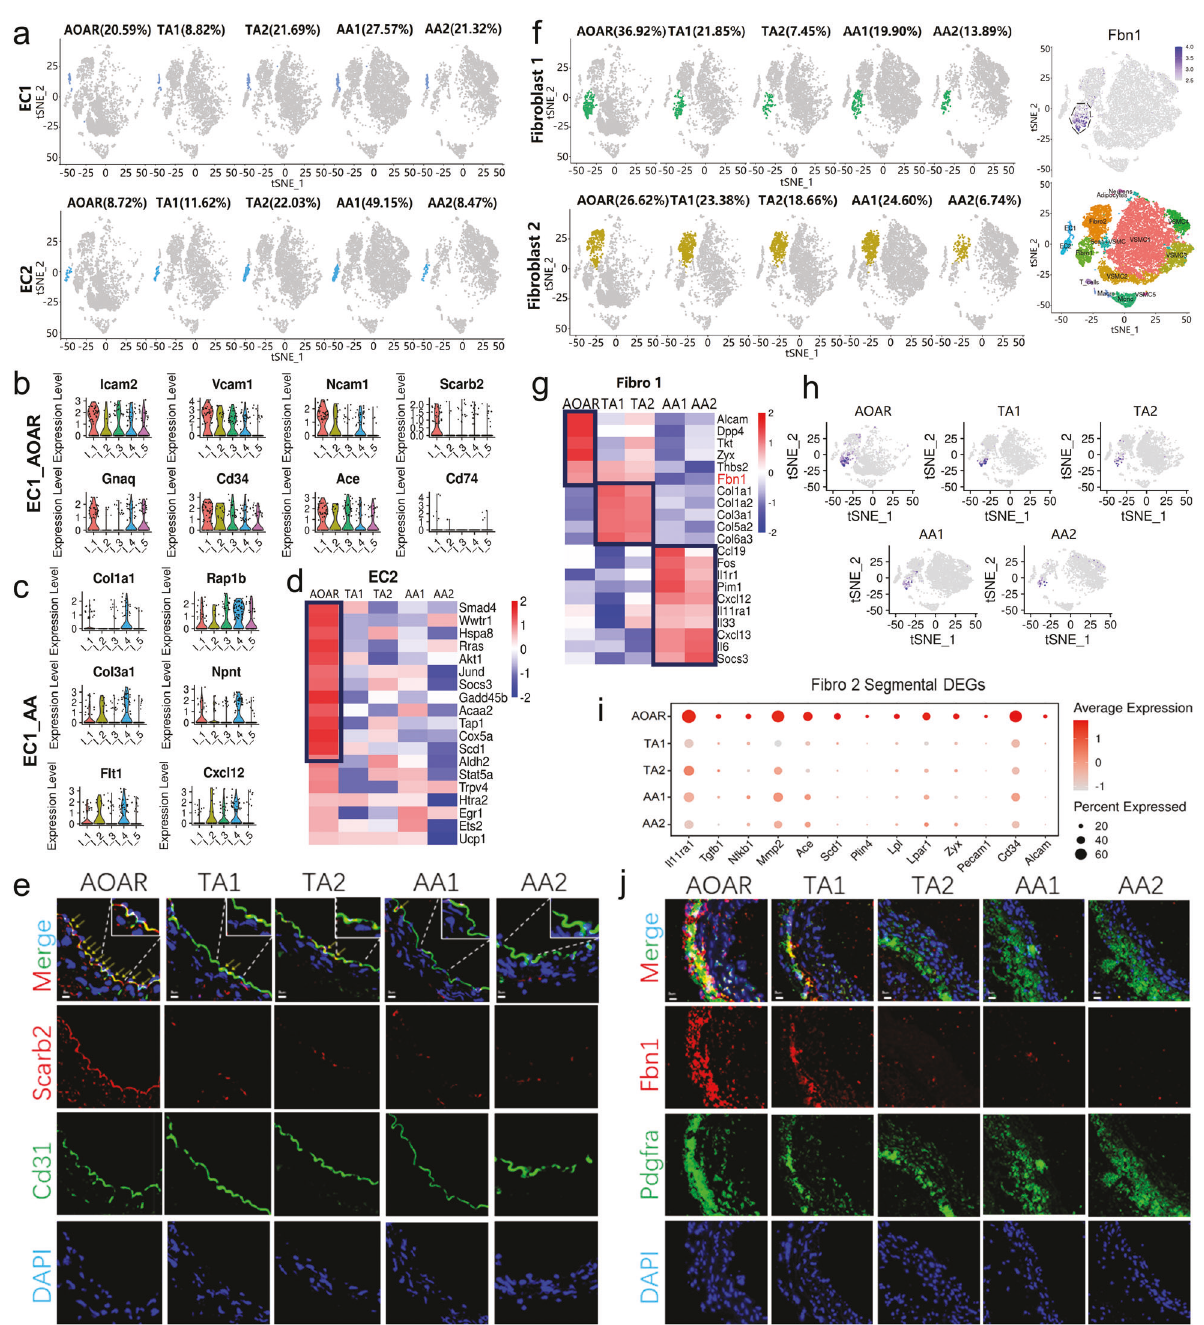
Fig. 2 Segmental DEGs in EC and fi broblast subtypes without differences in the ratio of distribution. a The t-SNE suggested the proportion of EC subtypes among fi ve segments without signi fi cant differences ( P > 0.05). b , c The enriched genes of EC1 with high expression mainly focused on the AOAR and AA1 segments, including focal adhesion genes, such as Vcam1 and Icam2 in AOAR and ECM metabolism genes, such as Col3a1 . I_1, I_2, I_3, I_4, and I_5 in X axes represented AOAR, TA2, TA2, AA1, and AA2, respectively. d The highly expressed genes of EC 2 were only enriched in AOAR including Smad4 and Scd1 , among others. e Veri fi cation of Scarb2 expression in ECs across fi ve segments showed that the expression of Scarb2 was enriched in the AOAR portion by immuno fl uorescent localization. The arrows and the partially enlarged images were used to indicate the expression of Scarb2 in ECs. Scale bar = 5 μ m. f The distribution of two fi broblast subtypes across fi ve segments was shown by t-SNE without a statistical difference ( P > 0.05). The feature plots showed that the Fbn1 + cells colocalized with fi broblast 1 when compared to that with all the cell types. g Segmental gene heatmap of Fibro1 with a signi fi cant spatial difference. The collagen-related genes Col1a1 and Col3a1 were highly expressed in TA segments, whereas in fl ammation factors Il1r1 and Il6 showed higher expression in AA segments. h Regarding spatial distribution, Fbn1 + cells were mainly distributed in the thoracic part of the aorta, particularly in the fi rst section, the AOAR. i The Fibro 2 expressed speci fi c differential genes mainly focused in the AOAR portion, such as Tgfb1 and Mmp2 . J Immuno fl uorescence staining showed that the expression of Fbn1 was high in the thoracic aorta, particularly in the aortic arch. Scale bar = 5 μ m. Each experiment was repeated independently for a minimum of three times